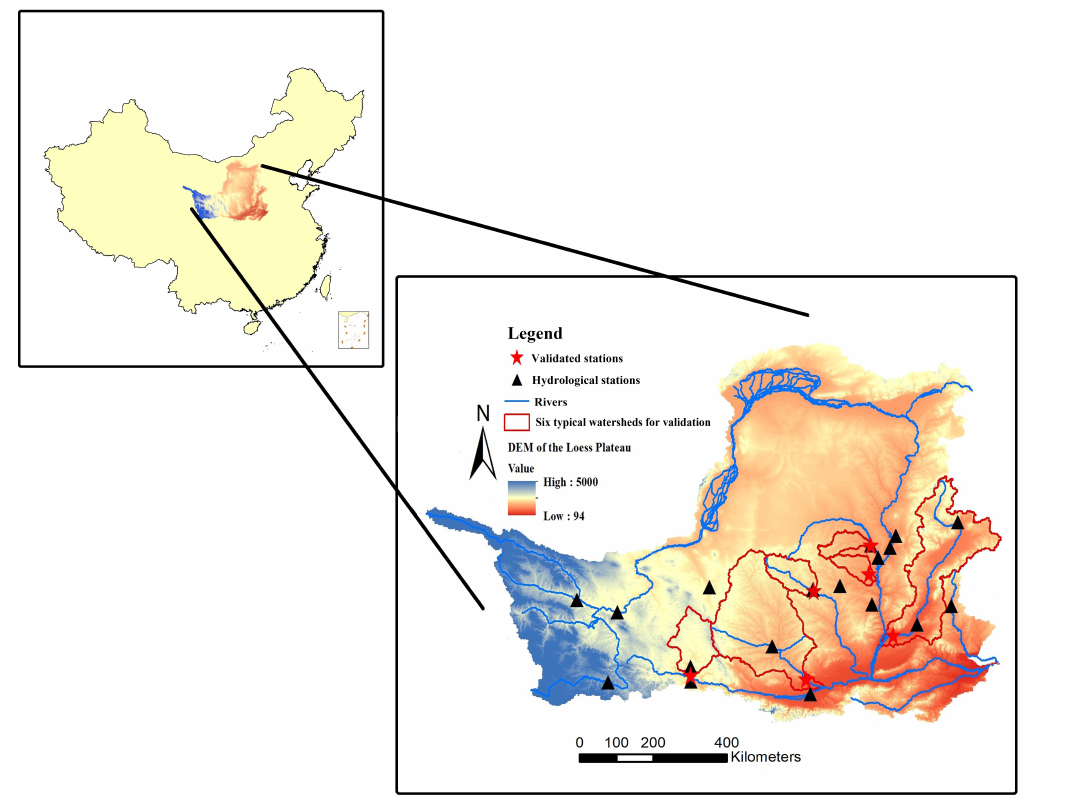
Figure 1. Location of the Loess Plateau and the distribution of the 18 hydrological